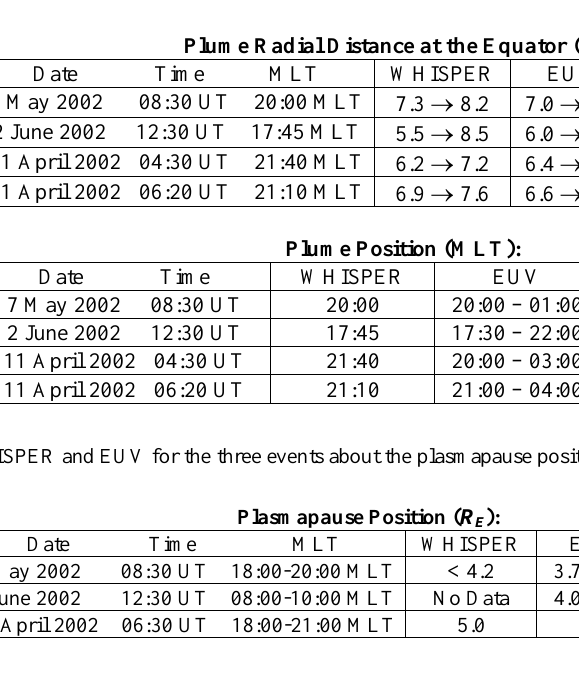
Table 2. Comparison between WHISPER and EUV for the three events about the radial distance of the plume and its MLT position.